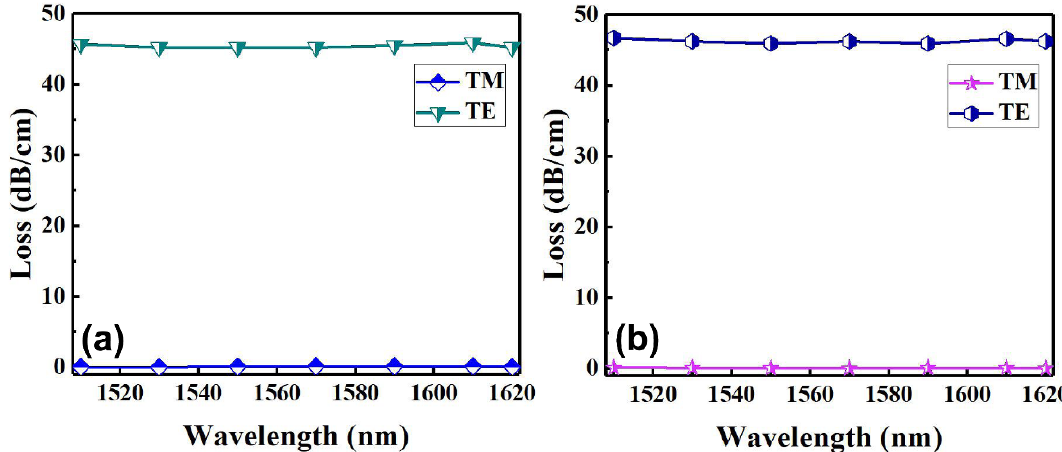
Figure 6. Graphene-induced losses measured for ( a ) Structure 1 and ( b ) Structure 2, respectively, in the wavelength range of 1510~1620 nm.